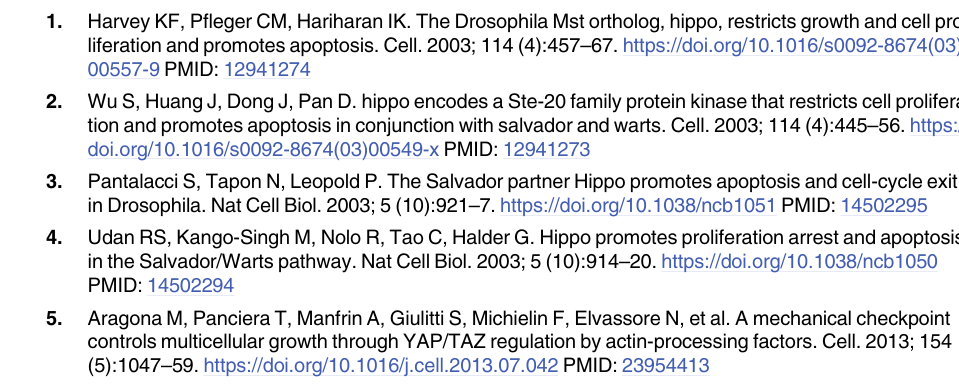
S4 Table. MS results of YAP